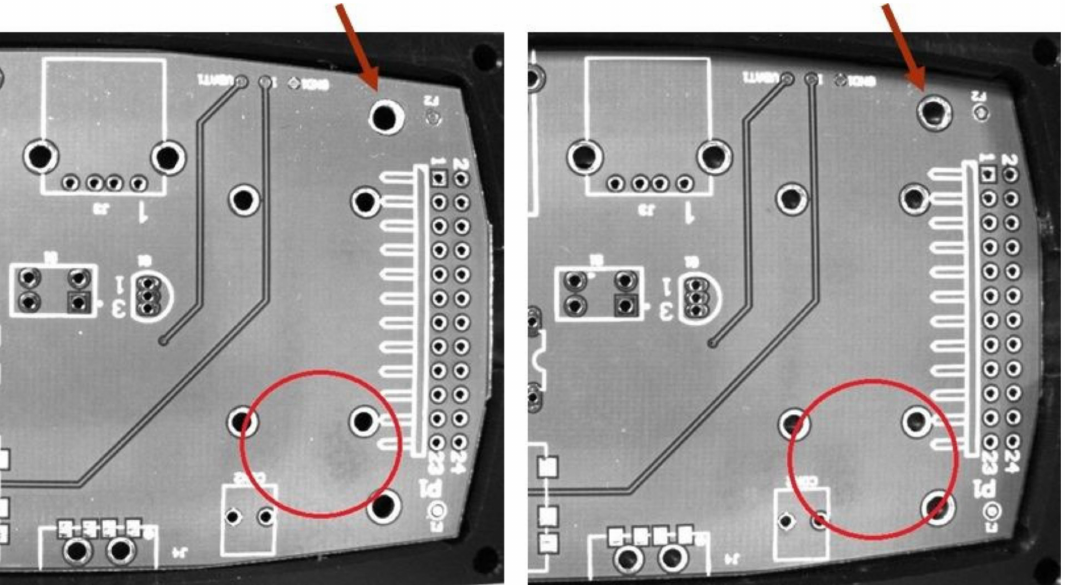
Figure 9. Missing ( left ) and present ( right ) washers (marked by arrows). Non-uniformed background looks like ghost images (marked by